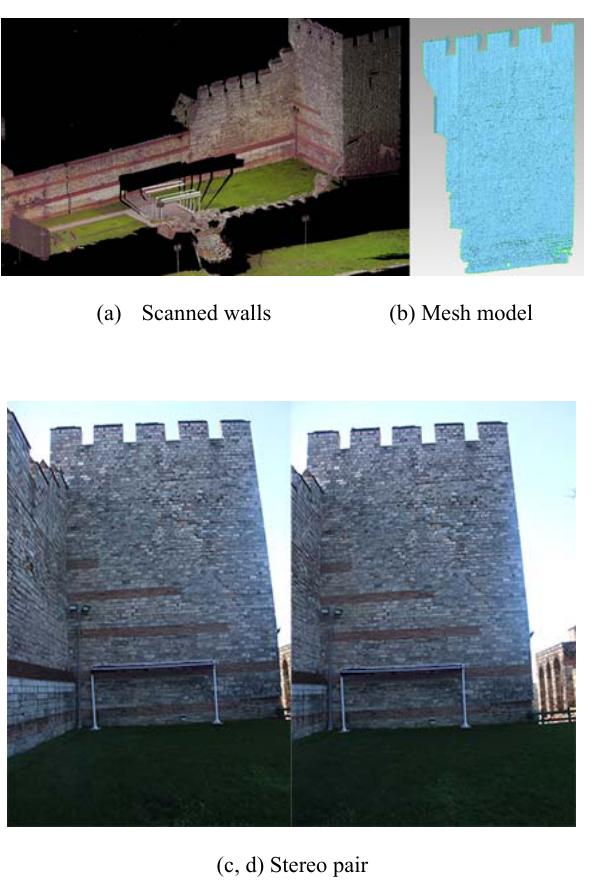
Figure-3 Scanned, mesh generated walls and stereo pair for photogrammetric evaluation